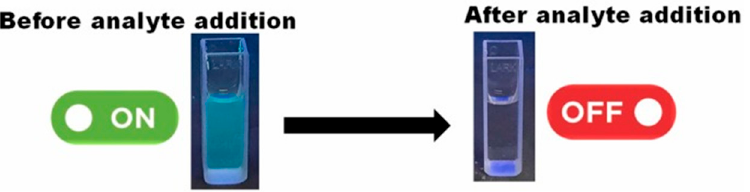
Figure 4. Fluoresce quenching of blue emitting BCCDs in the presence of Fe(III) ions reported in [85] . Reprinted with permission from Elsevier.